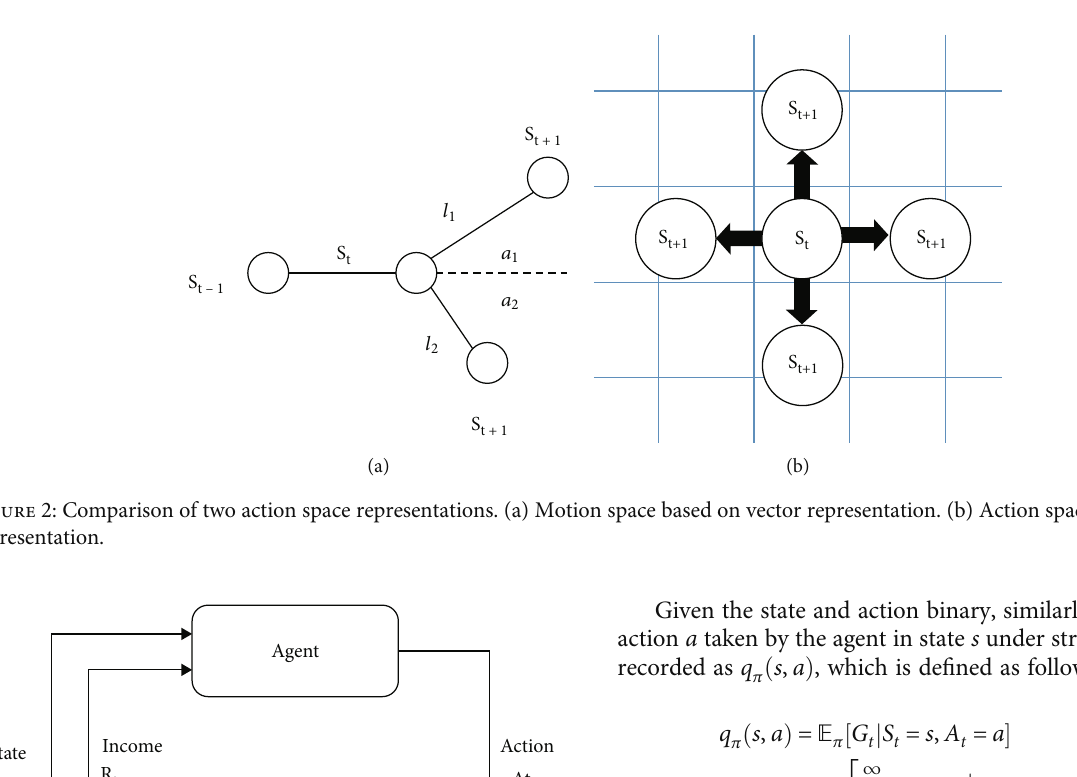
Figure 1: Evaluation index system of urban road network generation scheme.